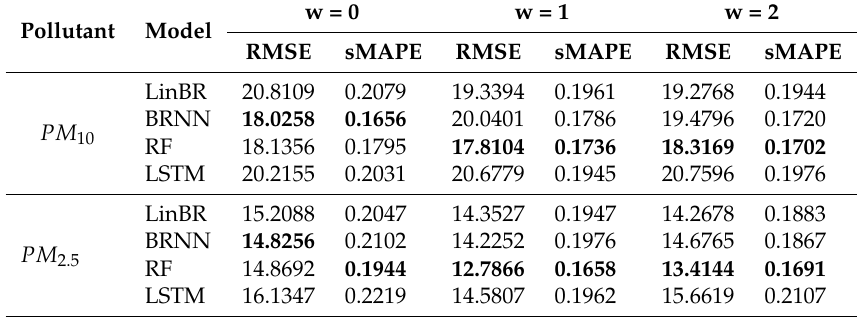
Table 7. Results of the selected models on the Daily Set. The results are again presented with RMSE and sMAPE on different time windows, corresponding to no lag, one-day lag and two-days lag.